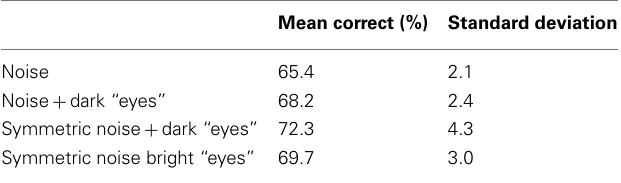
Table 4 | Recognition (new vs. old) rates for different classes of noise images in the memory task, based on the average responses of seven